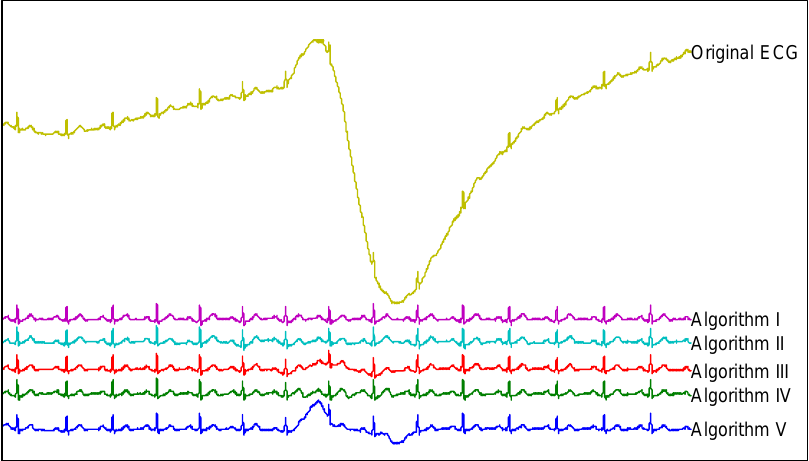
Figure 7. Comparisons of the five algorithms for suppressing severe BW (PTB record, s0130lrem, lead AVF, 00:10–00:21).